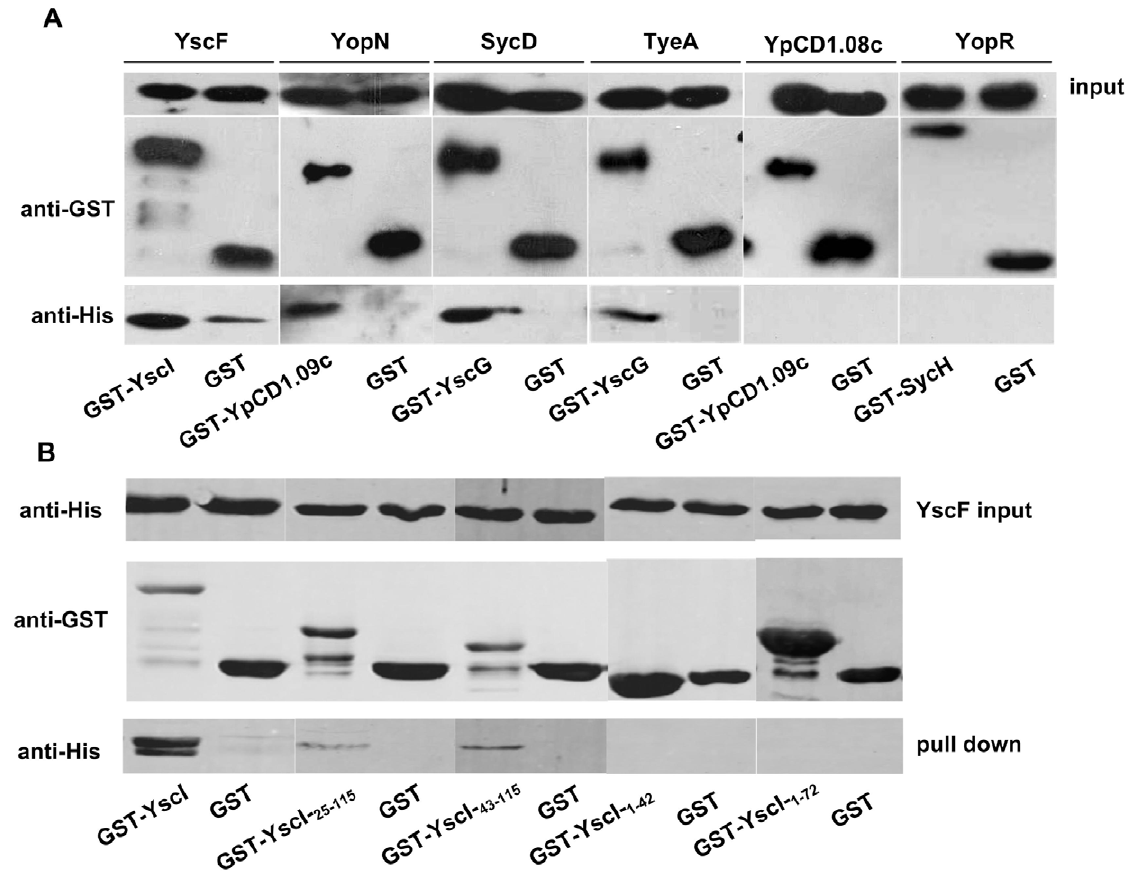
Figure 1. GST pull-down validation of novel interactions identified by yeast mating assay. GST pull-down results for six pairs of interaction are shown as labeled. Purified GST-tagged Y. pestis T3SS proteins were immobilized onto the glutathione sepharose beads 4B and incubated overnight with the putative interacting proteins that were identified by yeast mating assay. After extensive washing, the beads were added with 2 6 SDS buffer and boiled, and the proteins were separated by SDS-PAGE electrophoresis. The separated proteins were transferred onto the PVDF membrane followed by immunoblotting using anti-GST or anti-His antibodies. The top panel shows the His-tagged proteins that were loaded in each pull-down assay for GST or GST-tagged Y. pestis protein. The middle and the lower panels show the pull-down